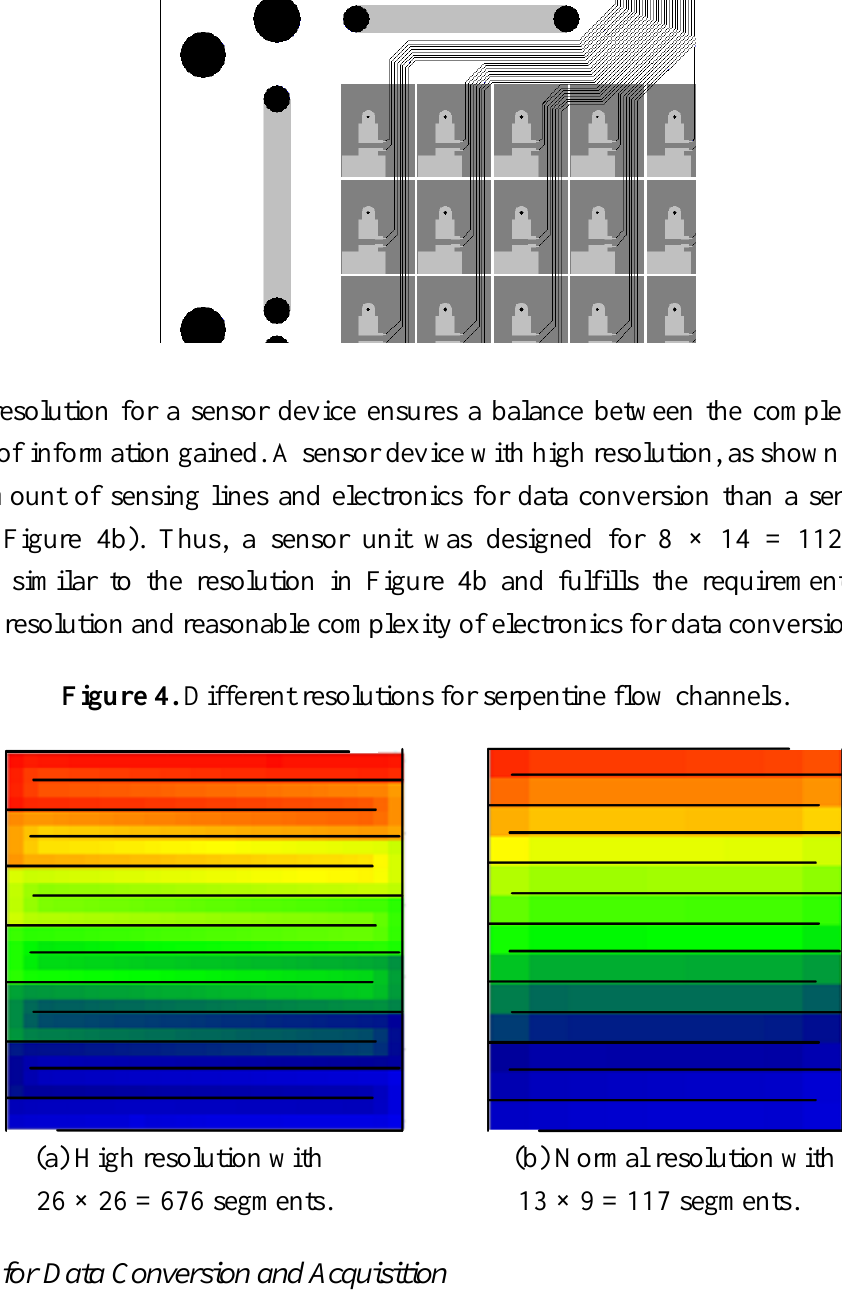
(a) High resolution with 26 × 26 = 676 segments.